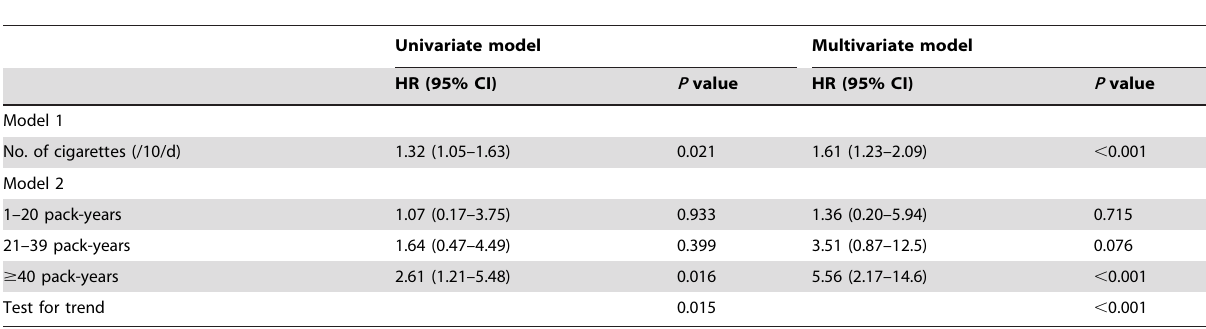
Table 3. Influence of smoking dose on the risk of a 30% decline in